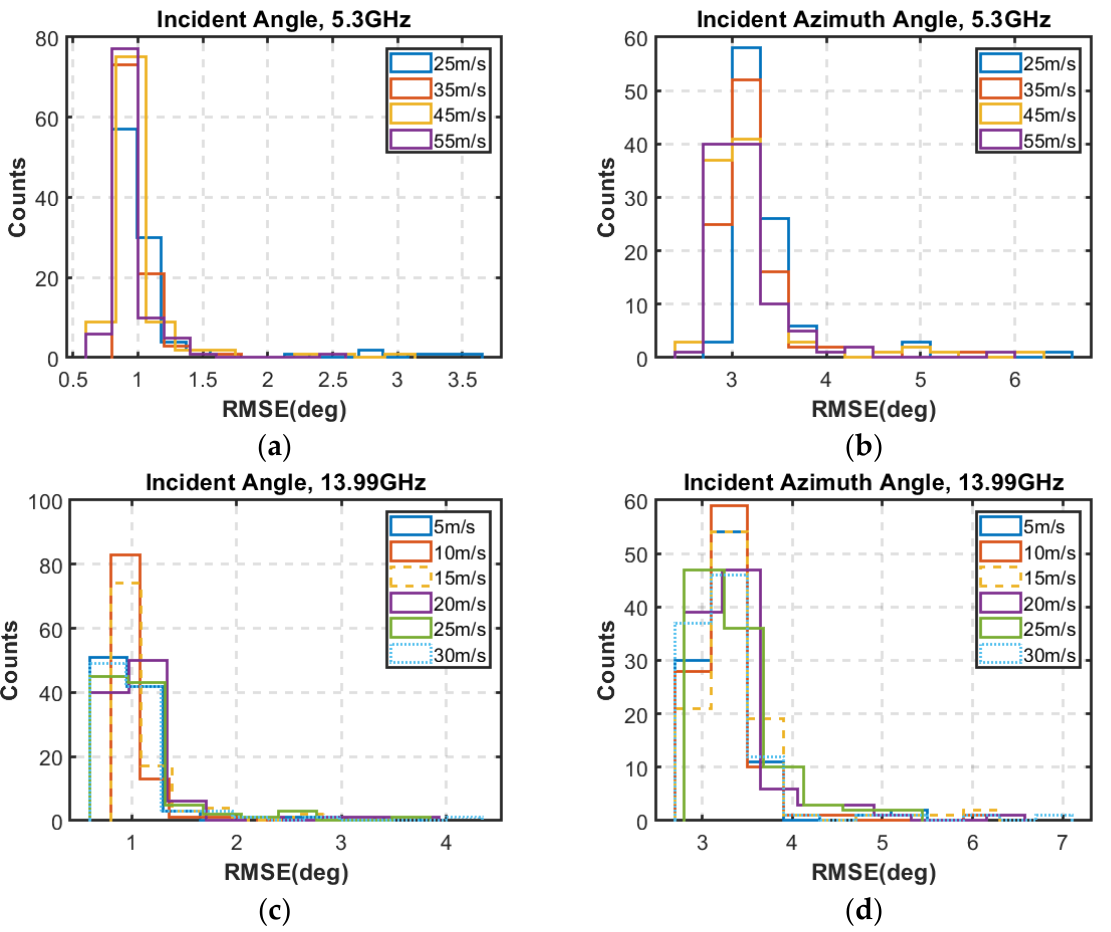
Figure 6. The distribution of RMSE between the truth and predicted incident source for datasets at 5.3 GHz and 13.99 GHz in 100 realizations: ( a ) 5.3 GHz, incident angle; ( b ) 5.3 GHz, incident azimuth angle; ( c ) 13.99 GHz, incident angle; ( d ) 13.99 GHz, incident azimuth angle.